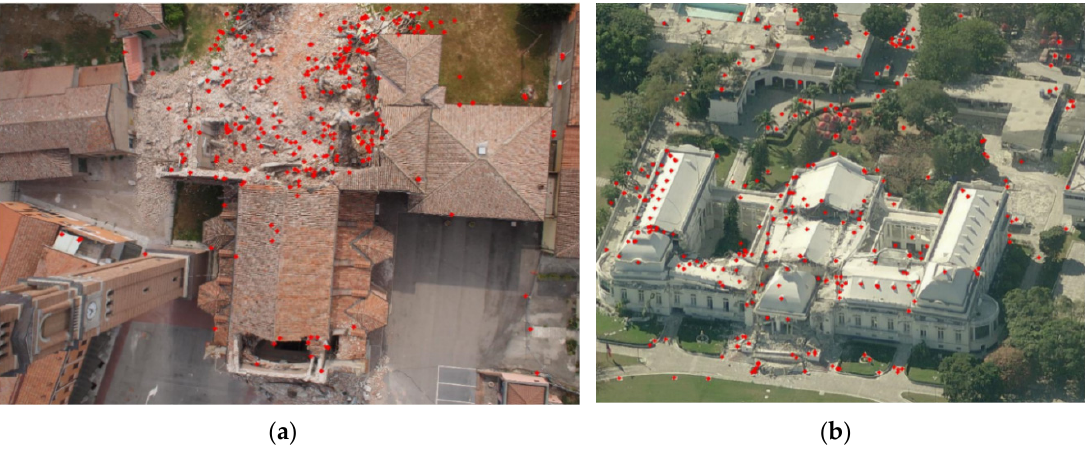
Figure 9. Detected SURF points are plotted on the image. ( a ) Strongest 300 SURF points among 4032 × 3024 pixels; ( b ) strongest 300 SURF points among 977 × 835 pixels. Images © Pictometry.